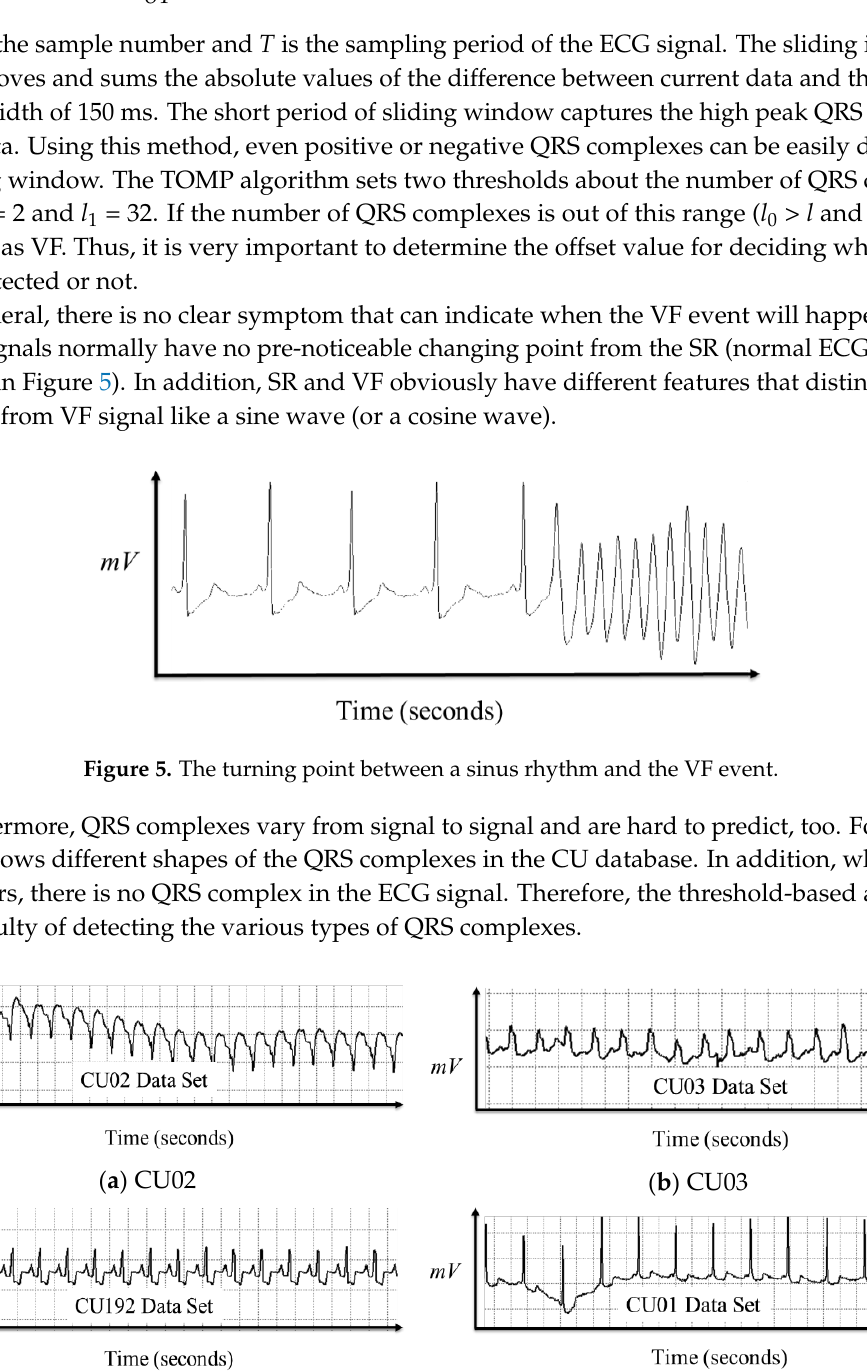
Figure 6. Different types of sinuous rhythms from CU database (62.5